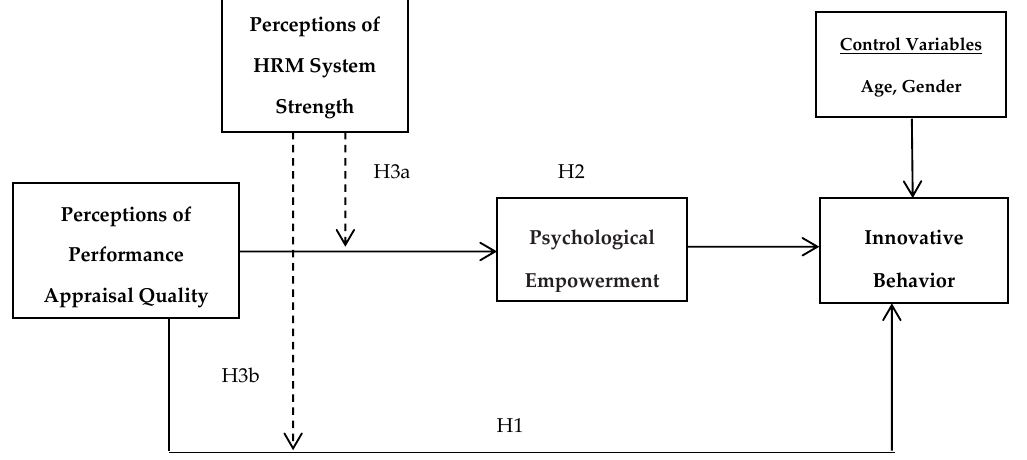
Figure 1. Research model